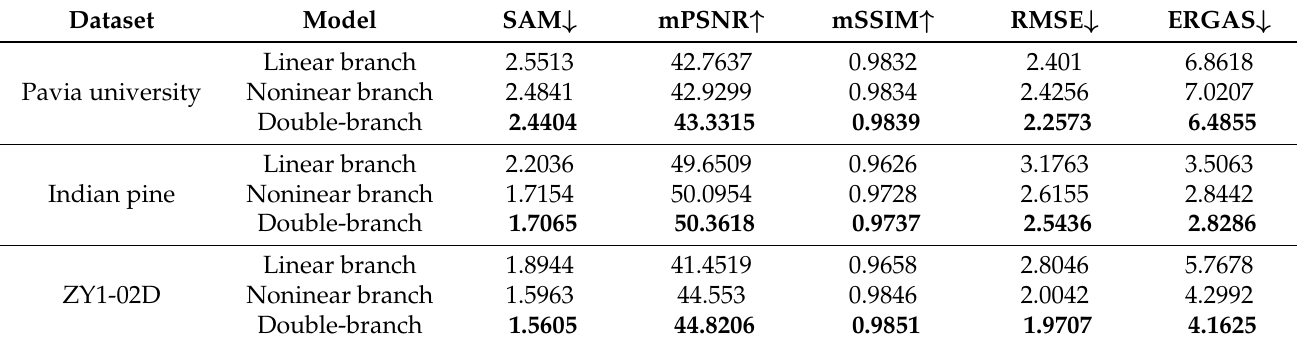
Table 5. The test results of single-branch and double-branch with three datasets. “ ↓ ” means smaller is better for this index. “ ↑ ” means bigger is better for this